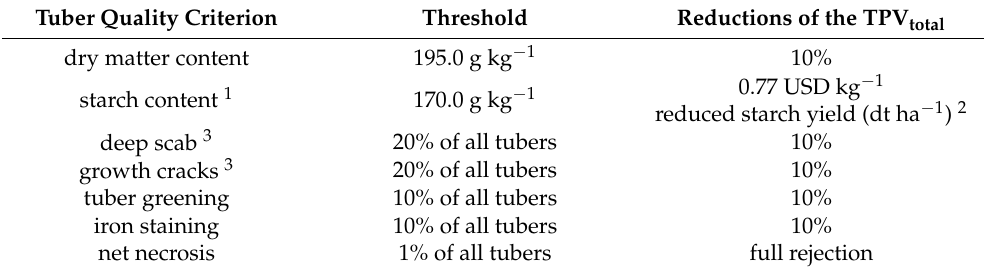
Table 3. Tuber quality thresholds and reduction (percentage) of the total production value (TPV total